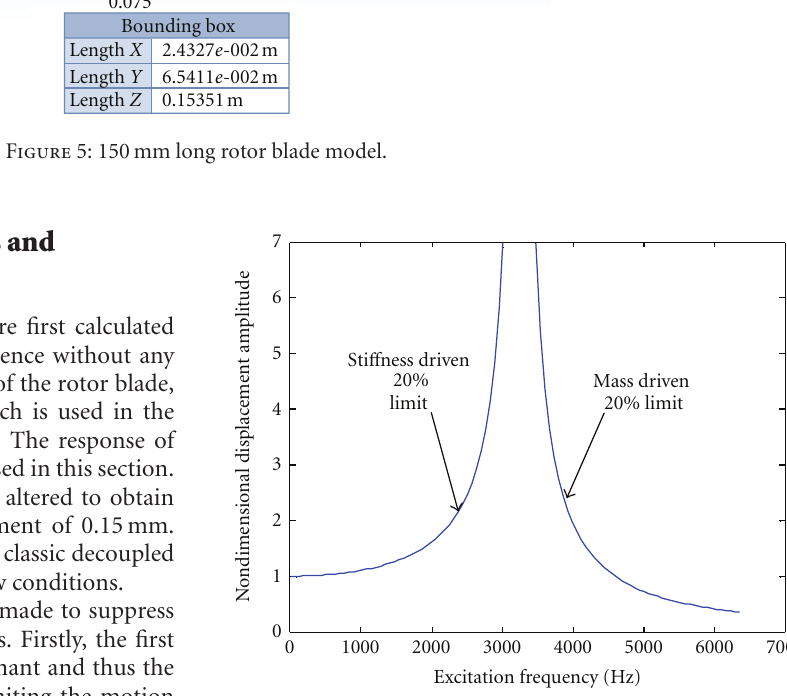
Figure 6: Nondimensional amplitude for the first mode with di ff erent driving frequencies. Shown are the chosen sti ff ness-driven limit 20% below the natural frequency and the mass-driven limit 20%